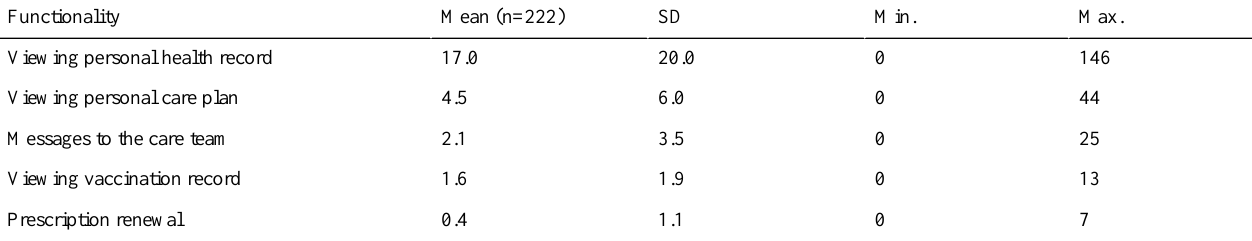
Table 2. Use of patient portal functionalities during the year after patient